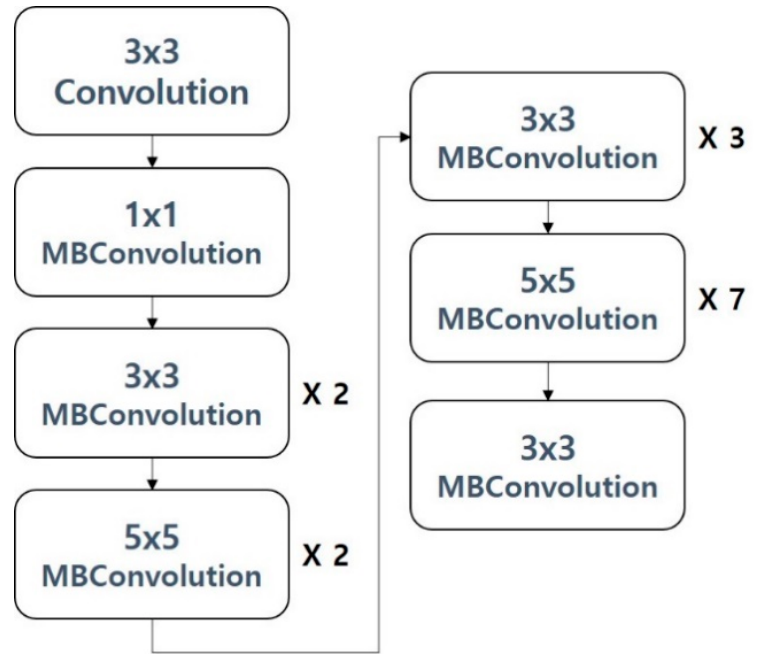
Figure 4. EfficientNet b7 model.